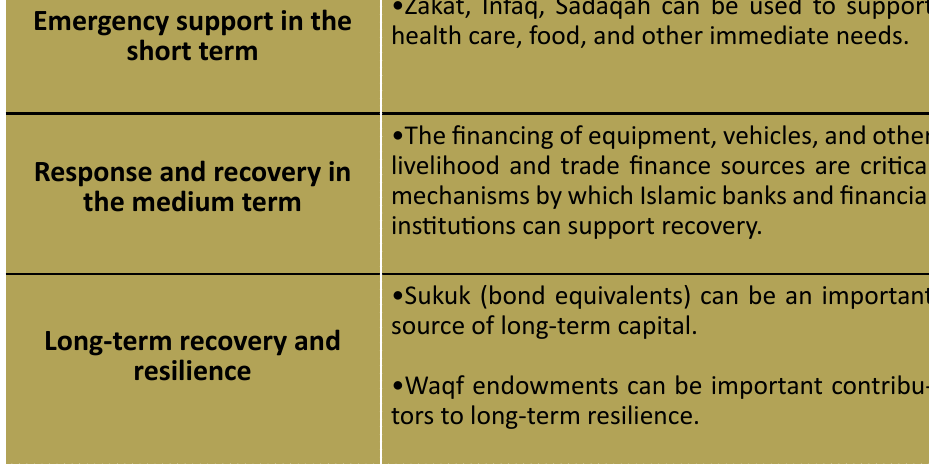
Table 1 : Islamic Finance Instruments and Their Role in the Pandemic Emergency support in